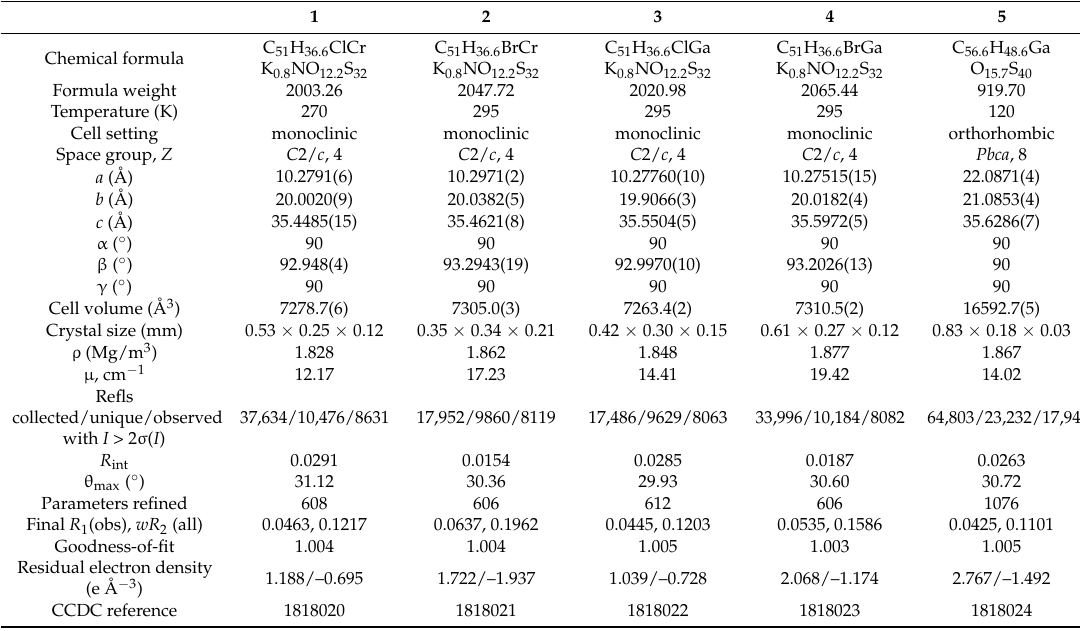
Table 1. Crystal structure and refinement